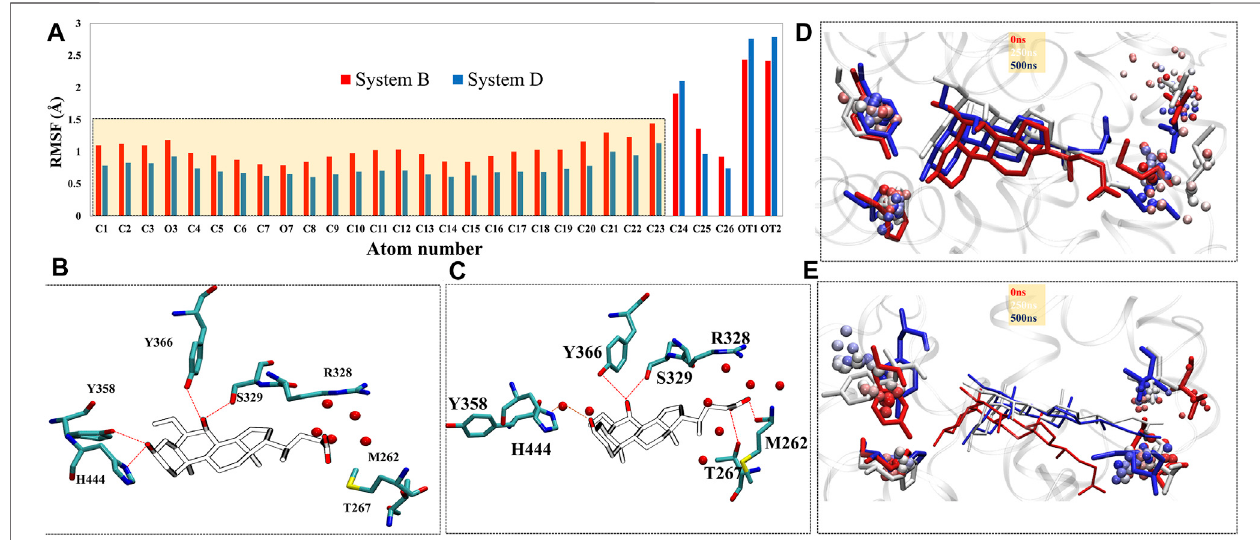
FIGURE 6 | The change in the residual positioning of the LBP (ligand binding pocket) of FXR. (A) The ligand RMSF plot for System B (red) and System D (blue) highlightingthedifferenceintheirvalues.Theatomic fl uctuationsintheheadandcoreregionsof ‘ OCA ’ arehigherinSystemBthanSystemD. (B,C) thepanelsrepresent HBinteractionbetweentheFXRresiduesand ‘ OCA ’ forSystemsDandB,respectively.Thereddottedlineisthedistancebetweenthe ‘ OCA ’ andtheresidueoftheFXR protein. The panels (D,E) represent the conformational sampling for theseresidues in Systems D and B during MD simulation shown in time step coloringmethod. The representatives of initial state (red: 0 ns), intermediate state (white: 250 ns) and fi nal state (blue: 500 ns) are shown in licorice representation while the beads representation shows the sampling of these residues throughout the trajectory by the stride of 1,000 frames at equal